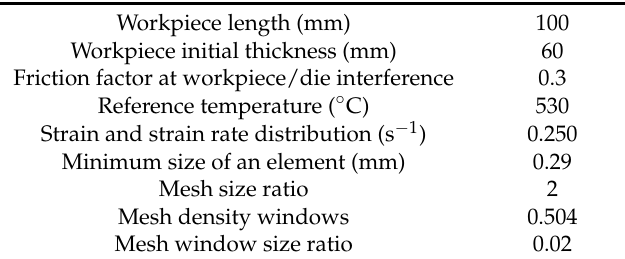
Table 2. Process parameter and frictional condition.